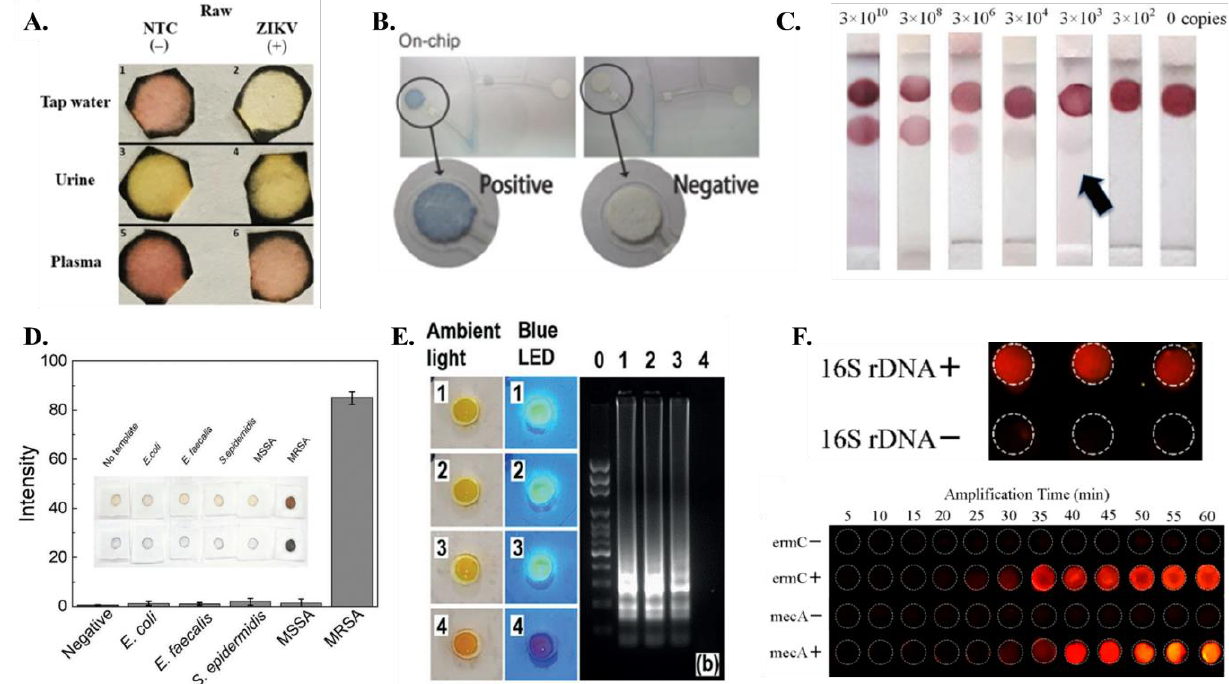
Figure 5. Detection methods ( A ) Colorimetric detection of ZIKV RT-LAMP assay on samples with tap water, urine and plasma [from [44], copyright 2018 Springer Nature]. ( B ) Colorimetric signal detection on On-chip [from [60] copyright 2016 Wiley-VCH GmbH]. ( C ) The integrated paper-based LFA device can achieve the colorimetric detection limit of as low as 3 × 10 3 copies at the optimum incubation time of 60 min [from [58], copyright 2016 Royal Society of Chemistry]. ( D ) The application of gold nanoparticles (AgNPIs) with paper pad enable quantitative assay readout [from [69], copyright 2021 Wiley-VCH GmbH]. ( E ) Smartphone photos of the detection units under the ambient light and blue LED flashlight to detect 1, 0.5, and 0.1 PFU of ZIKV spiked in human urine samples while device 4 is a negative control. [from [62], copyright 2018 Wiley-VCH GmbH]. ( F ) (top) Fluorescence image of the paper-based chip for 16S rDNA detection; (bottom) Real-time amplification of multiple LAMP for mecA and ermC. Fluorescence intensity of amplification changes with time. [from [63], copyright 2018 American Chemical